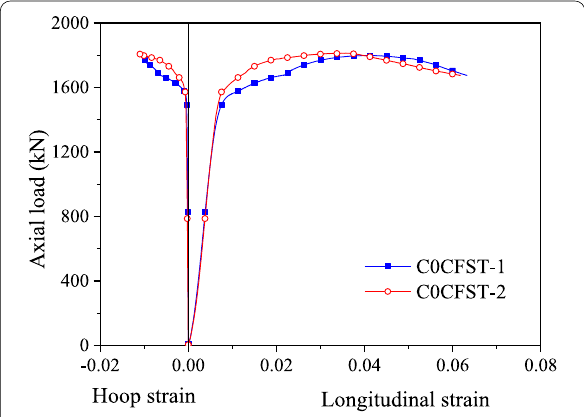
Fig. 11 Axial load–strain curves of unconfined CFST